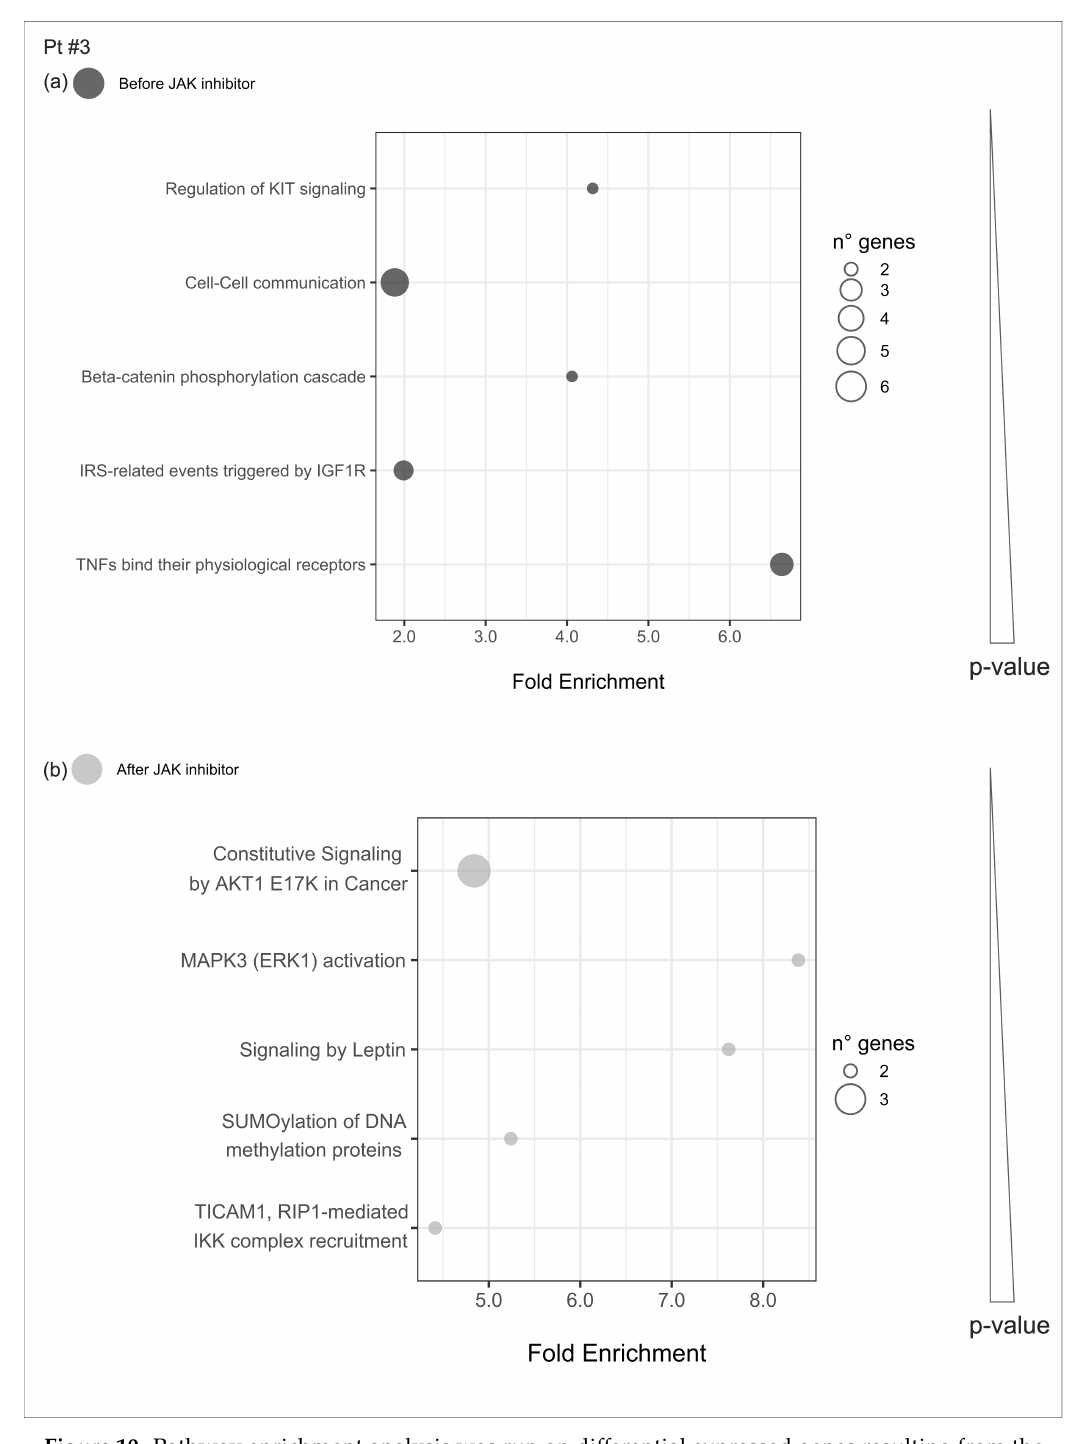
Figure 10. Pathway enrichment analysis was run on di ff erential expressed genes resulting from the comparison between patient #3 before JAKinhibs and the control-group subjects and between patient #3 after JAKinhibs and the controls. Pathways altered uniquely before ( a ) or uniquely after ( b ) JAKinhibs were chosen. Each dot represents a pathway, and the size is directly proportional to the number of genes. On the X -axis is displayed the pathway fold enrichment. All the selected pathways showed a lowest adjusted p -value of the given term over all iterations ≤ 0.01, and the five most enriched pathways were elected, where applicable. Pathways are ordered by increasing p -values. Pathways altered before JAKinhibs are colored in dark grey and those altered after JAKinhibs in light